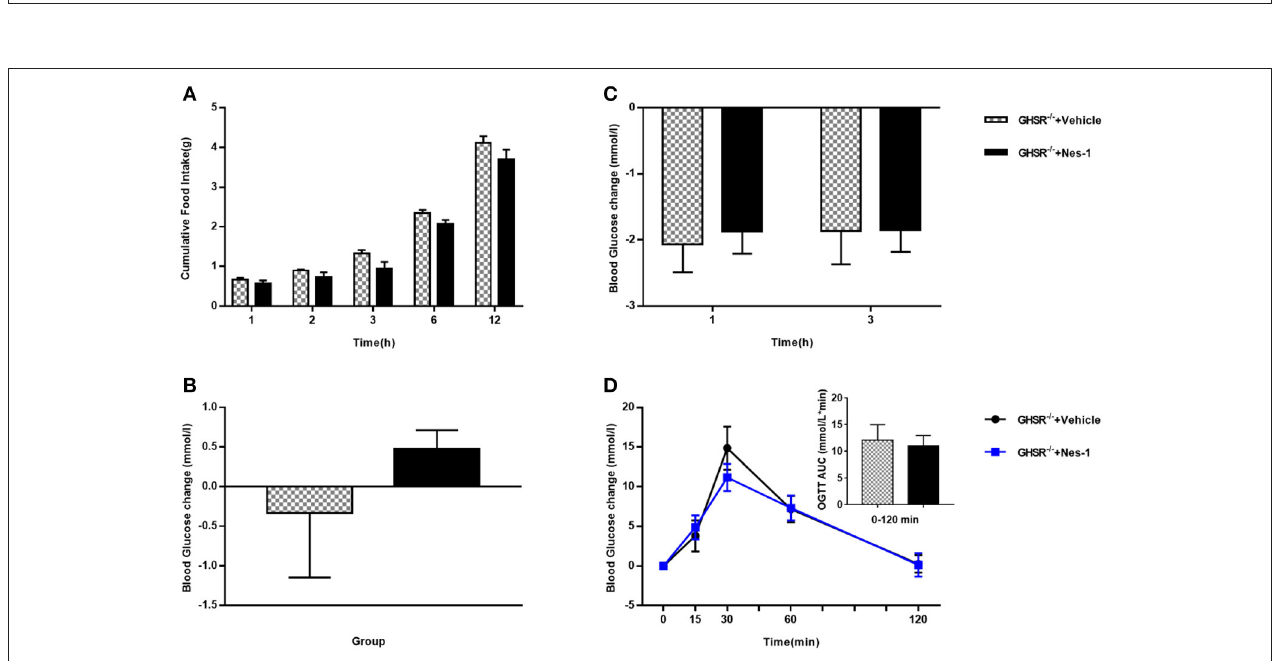
FIGURE 4 | Ghrelin receptor knockout blocked nesfatin-1’s effects on glucose metabolism in NCD-fed mice. GHSR − / − mice fed NCD underwent chronic tail vein administration of vehicle or nesfatin-1 (Nes-1) for 11 days. (A) Food intake and (C) blood glucose changes after one acute injection in mice fasting for 6h. (B) Blood glucose changes after 11-day chronic injection compared with drug treatment prior. (D) OGTT after 8 days of injection in mice fasting for 16h. Data are expressed as mean ± SEM. GHSR − / − + Vehicle: n = 3; GHSR − / − + Nes-1: n = 4. No statistical significance is detected. Student’s t -test was applied to analyze the statistical